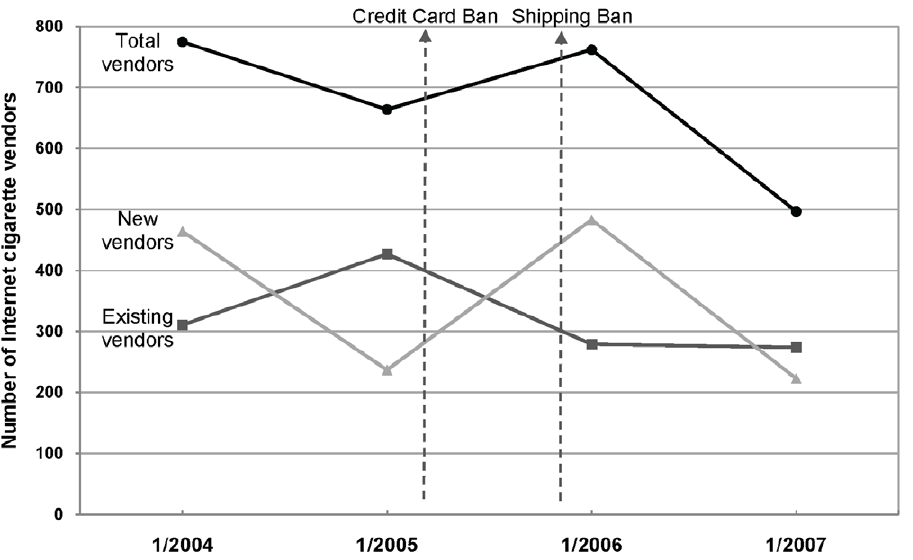
Figure 2. Internet cigarette vendors before and after the credit card and shipping bans. Distribution of new vs. existing Internet cigarette vendors before and after the credit card and shipping bans, 2004–2007.